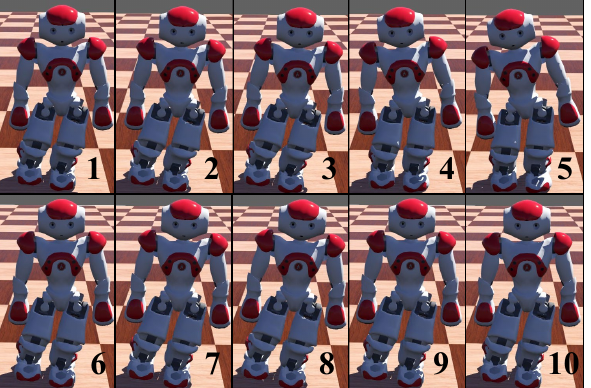
Figure 8. Snapshot sequences of single-leg support. The posture of standing on single support foot can be maintained even under the action of external force, F ext = 7 N acting on the left shoulder. ( 1 – 5 ): without CPG, the robot can not hold the posture, swing to left side first and then lean to the right side following the Newton’s first law of motion. ( 6 – 10 ): with CPG, the robot keeps standing on single